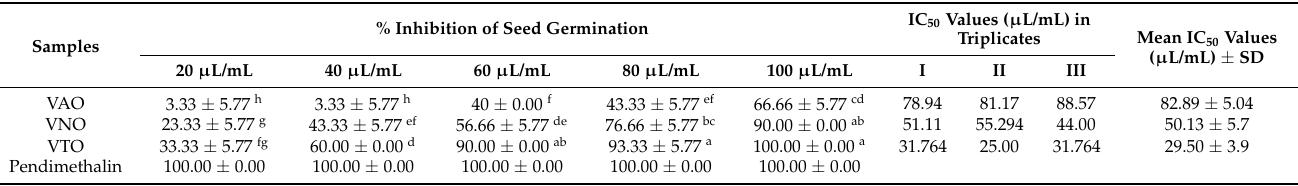
Table 2. Mean % inhibition and IC 50 values for seed germination inhibition by tested essential oils.